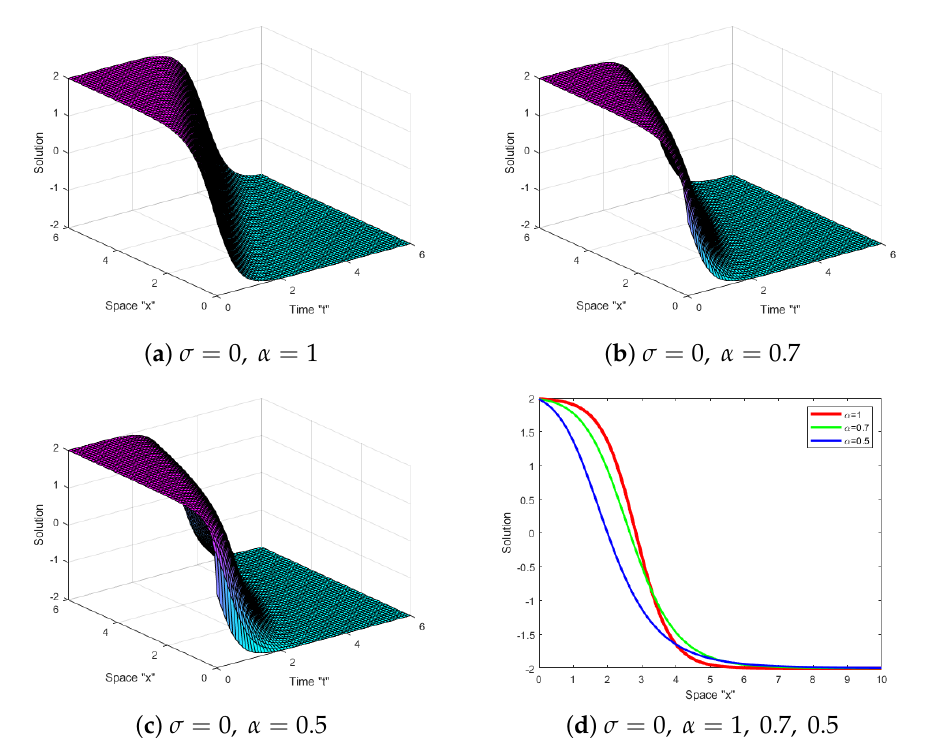
Figure 2. ( a – c ) show the 3D profiles of Equation (18) with σ = 0, c 0 = − 4, and different values of α . ( d ) indicates the 2D profile of Equation (18).